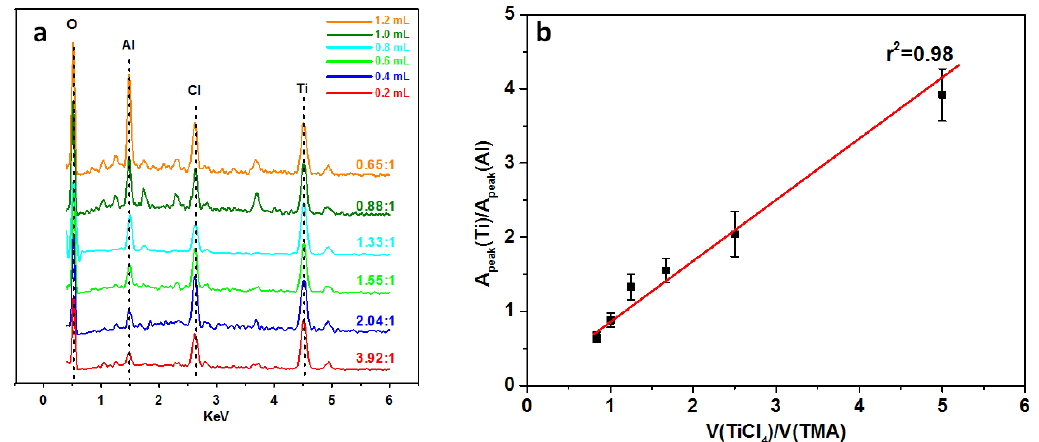
Figure 3. EDS spectrums ( a ) and ratio-control of Ti and Al ( b ) in different fibers (the error bars indicate the standard deviations of the